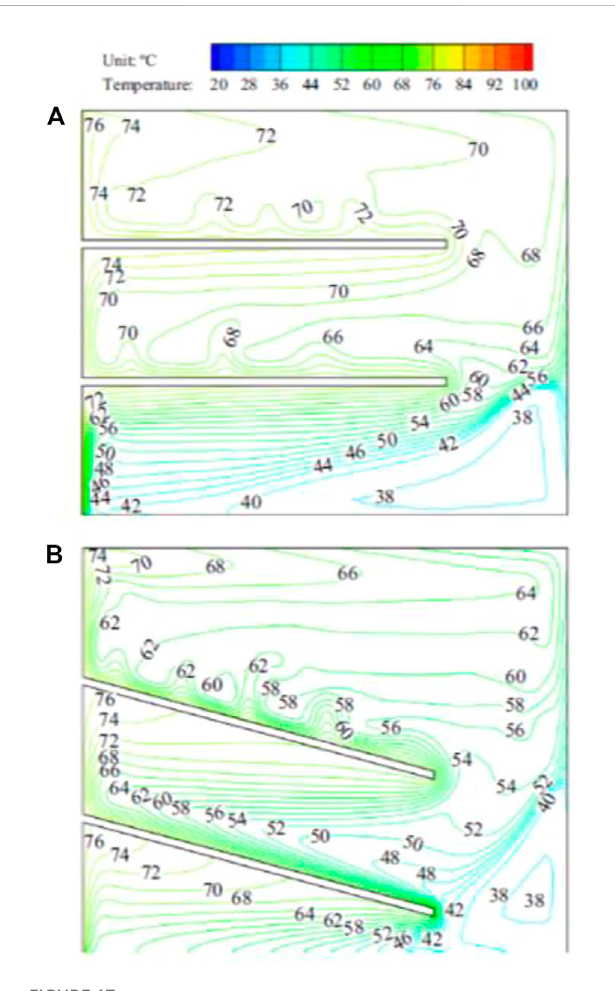
FIGURE 17 Temperature contours lines in the PCM domain at t = 10,000 s: (A) θ = 0 ° and (B) θ = 15 ° , with l/L = 0.75 and q n = 2500W/m 2 (Ji et al.,